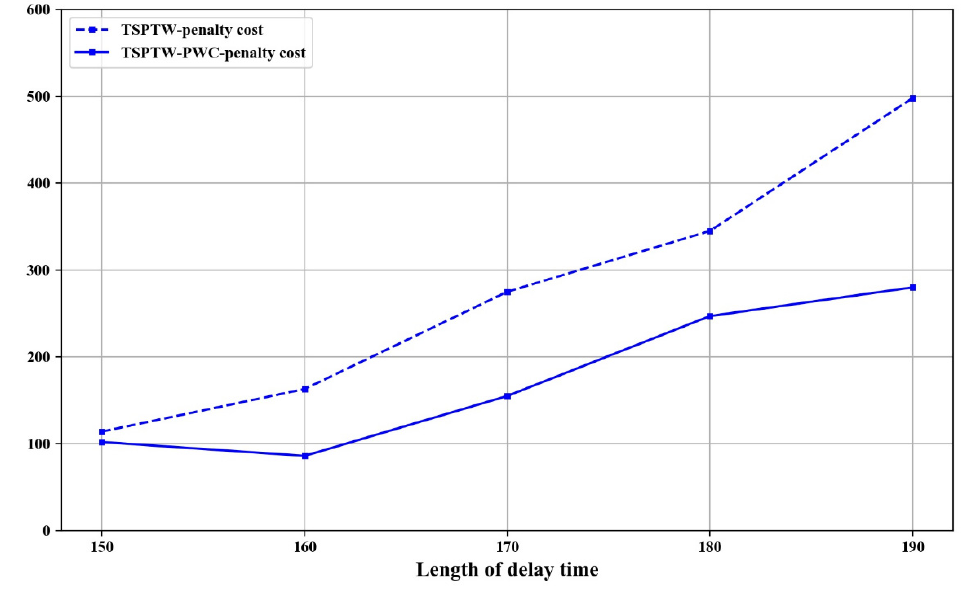
Figure 4. Penalty cost comparison for different delay time.